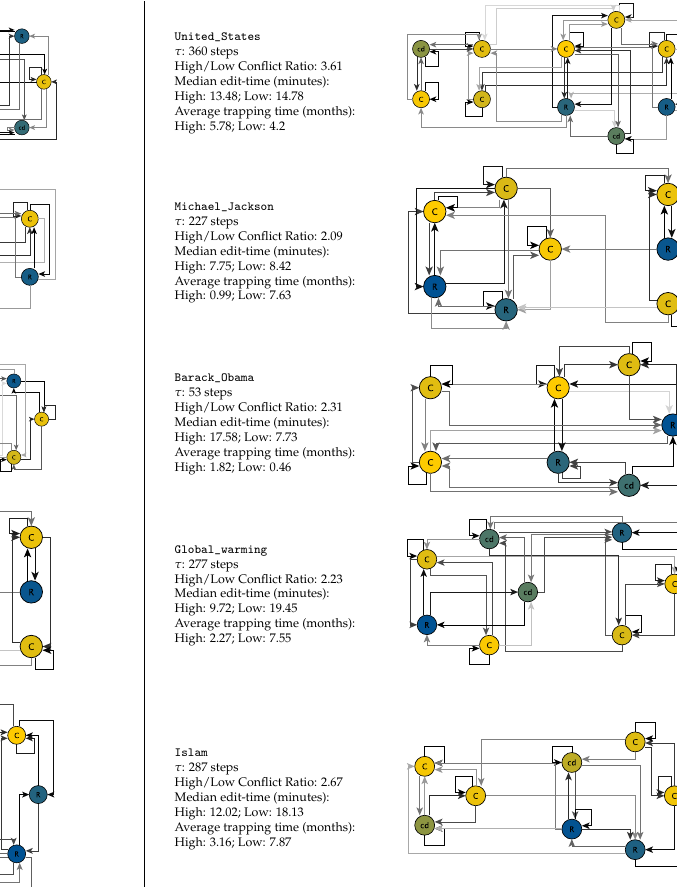
Table 1. Hidden Markov models and derived parameters for cooperation and conflict on the ten most-edited pages on Wikipedia. Editing patterns are characterized by high levels of determinism, and long timescale trapping in distinct higher and lower conflict